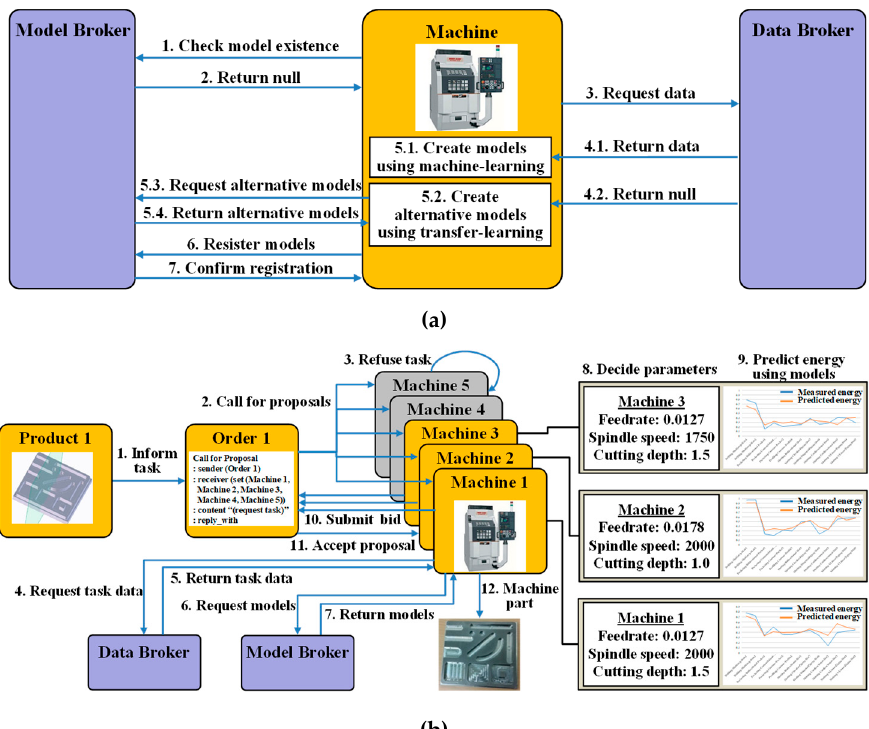
Figure 10. A test part and a set of machining conditions.